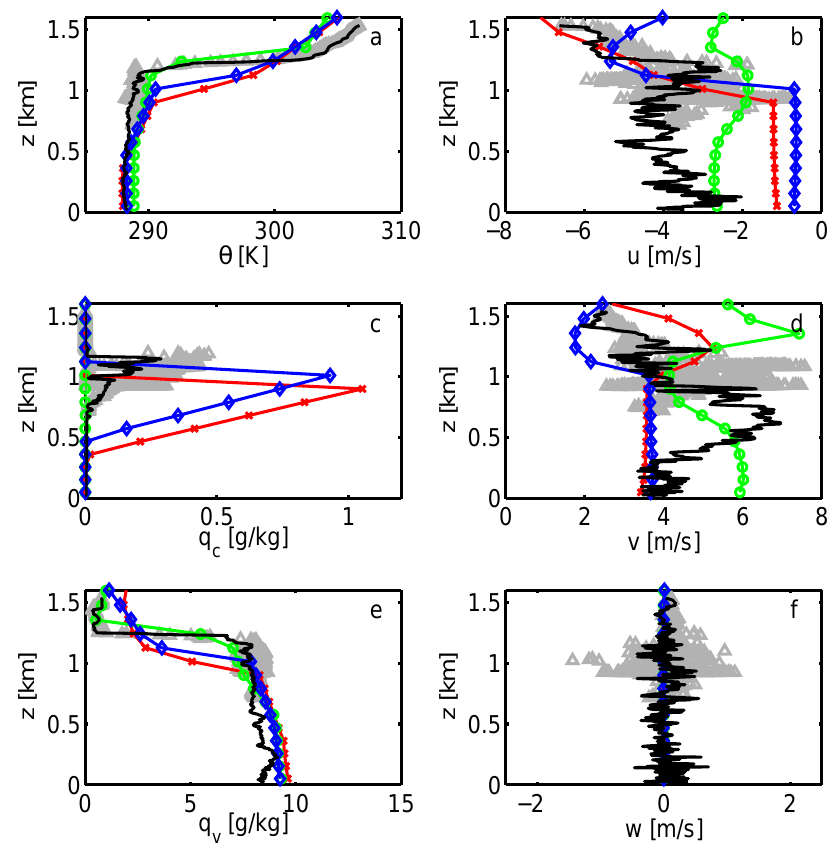
Fig. 6. Model sensitivity to the initialization time for EXT with 81 vertical levels and for profile 5; black line – observations, blue – 00:00UTC on 12 November 2008, green – 00:00UTC on 10 November 2008, red – 00:00UTC on 5 November 2008; gray points – variability of measurements.